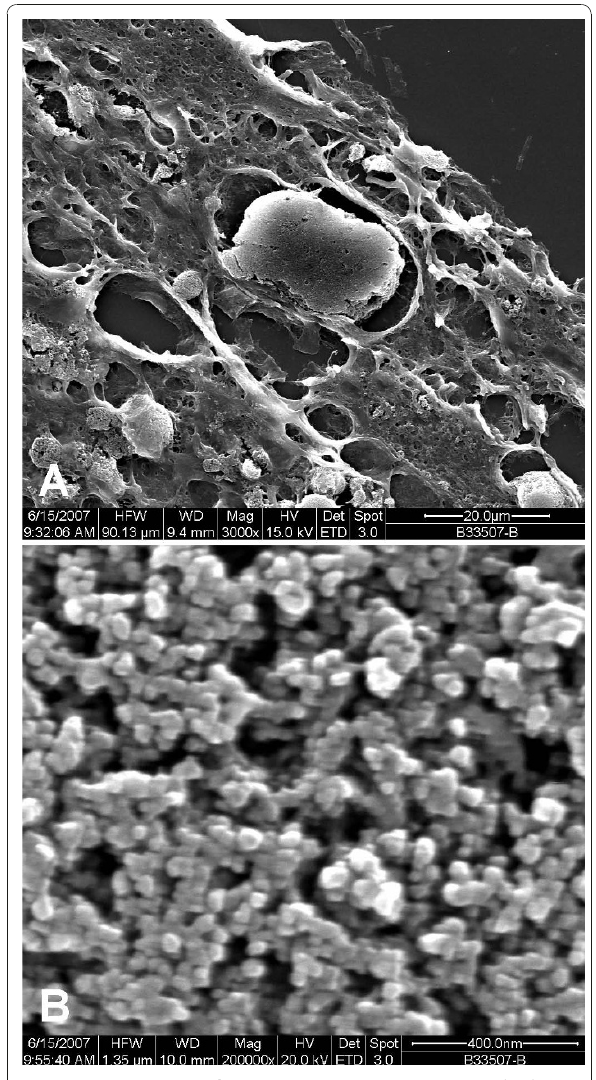
Figure 2 Scanning electron microscopy . SEM reveals dense aggregates of foreign material with variable diameters (A, 3,000×), High magnification shows NP with a diameter between 31 and 67 nm (B,